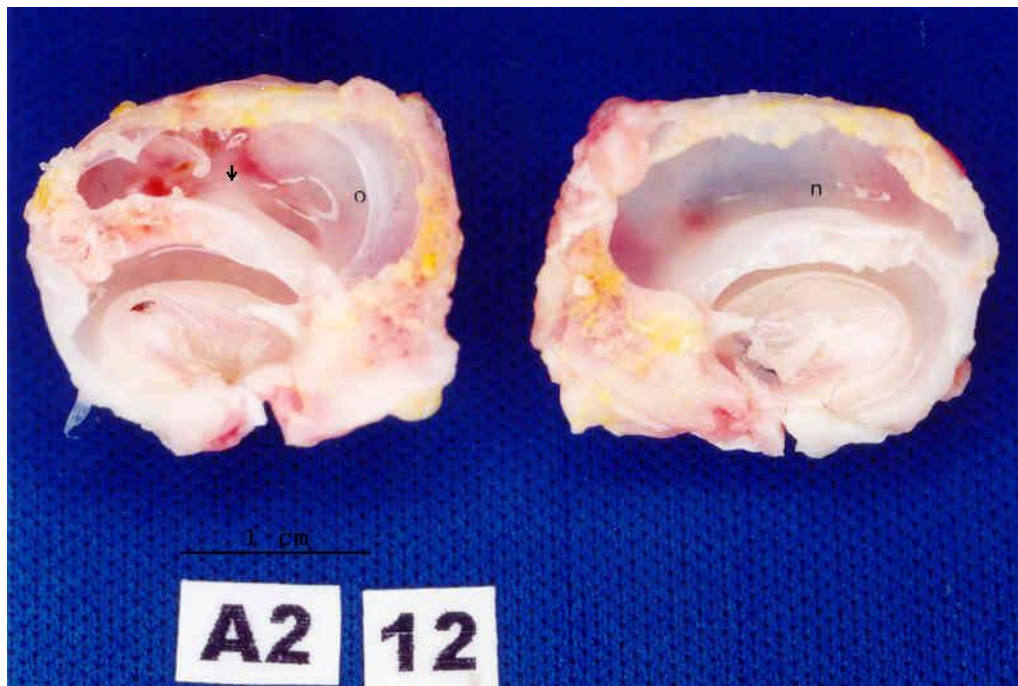
FIGURE 3 - Macroscopic aspect of the tympanic bullae of cat 12 of group A2. The concavity of the operated bulla (o) is similar to the normal one (n). Observe the light protuberance in the inner surface of the larger compartment (arrow)